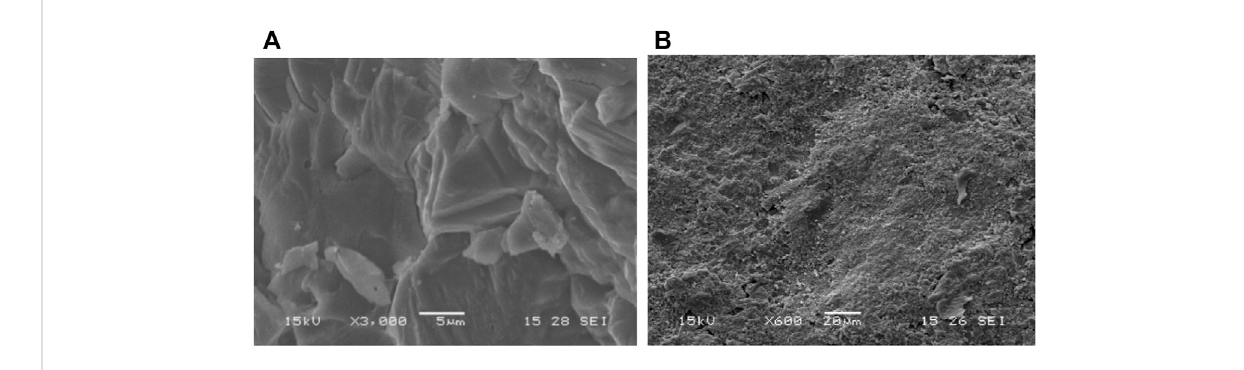
FIGURE 1 SEM images of the rocks. (A) Phosphate rock, and (B) granite.